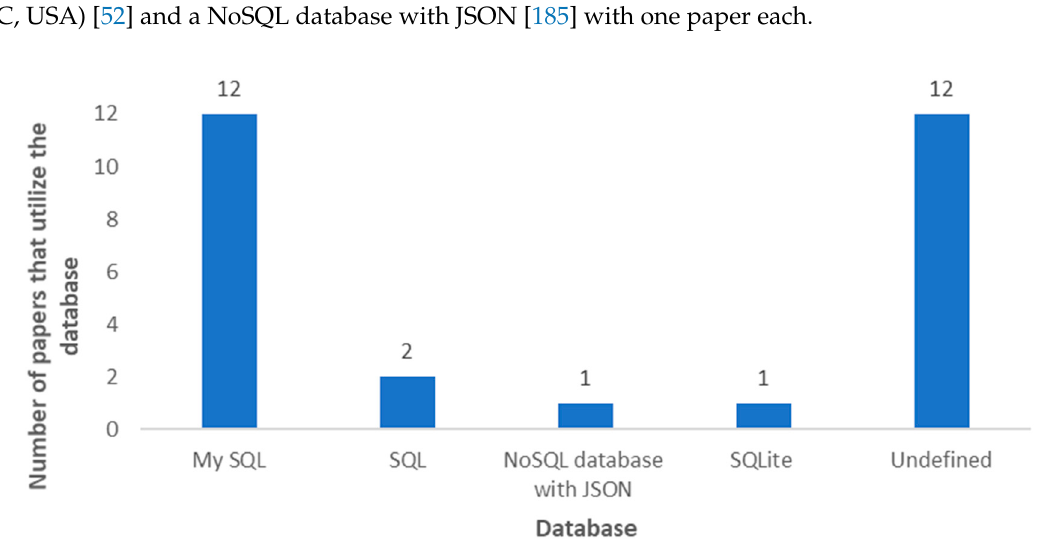
Figure 28. Number of employed Databases to store data of IoT nodes for irrigation systems.